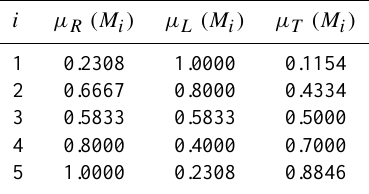
Table 4. Determination of µ total